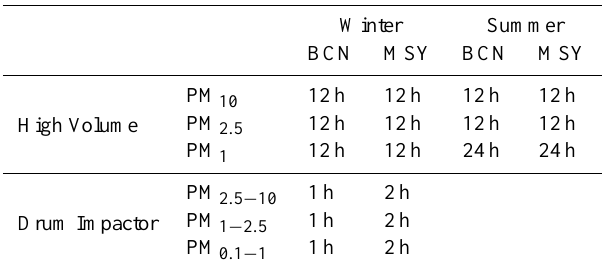
Table 1. Frequency and time resolution of measurements carried out during winter and summer campaigns at both Barcelona (BCN) and Montseny (MSY)